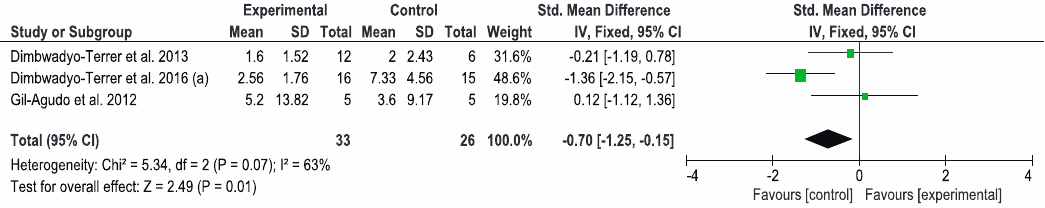
Figure 4. Forest plot for functional performance measured by FIM scale. A green block indicates the weight assigned to the study and the horizontal line depicts the confidence interval. A black rhombus shows the overall result.